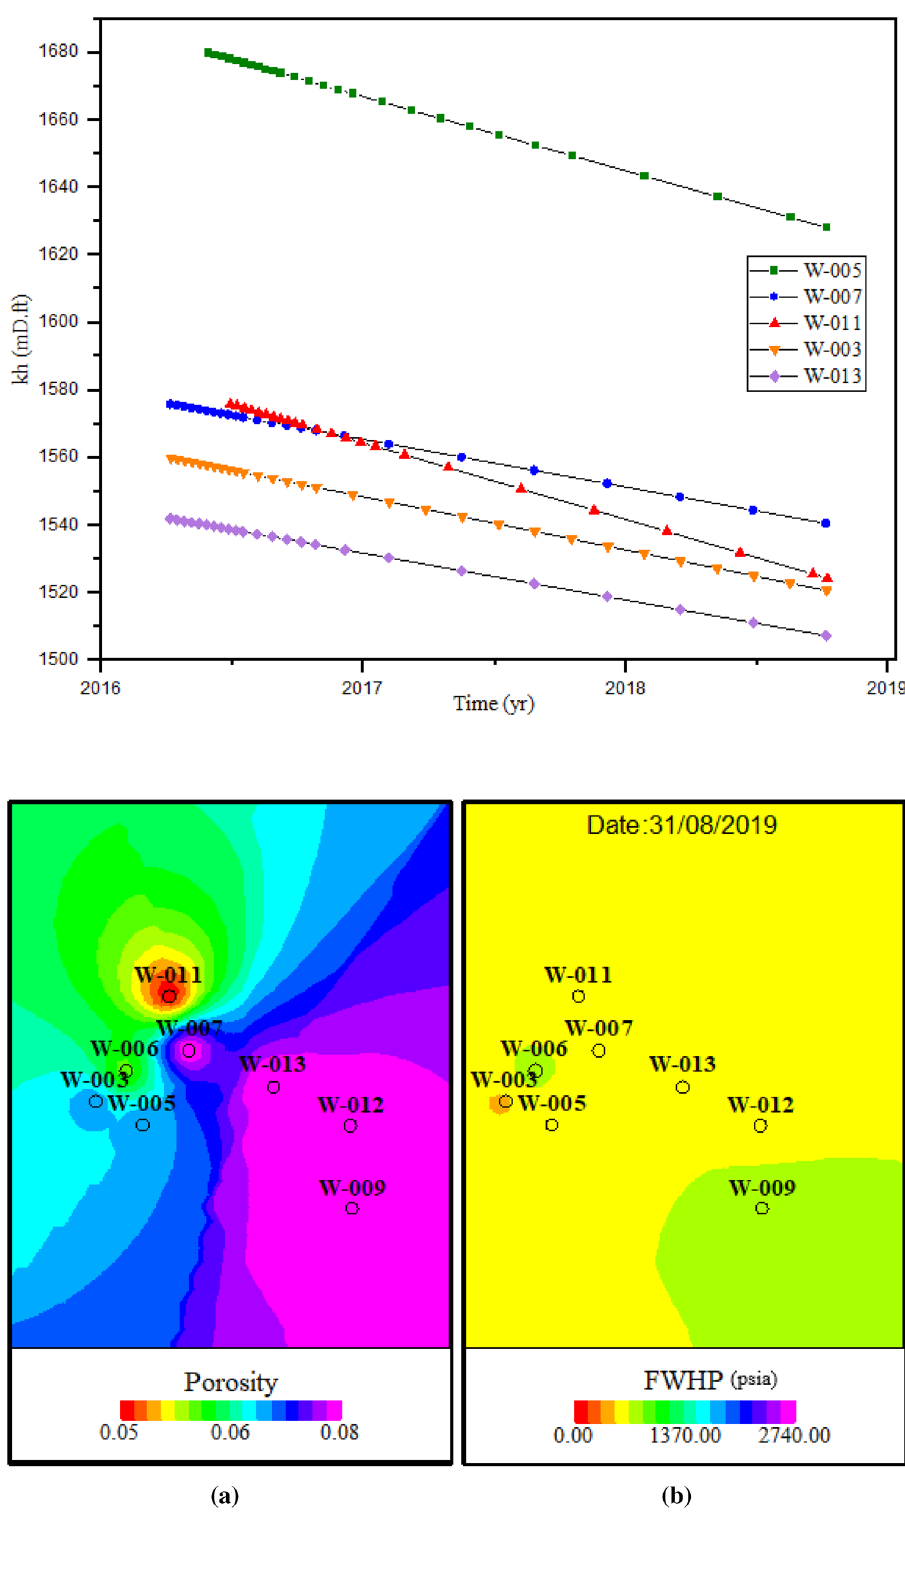
Fig. 7 kh changes over pro- duction time for the wells with the same range of initial k